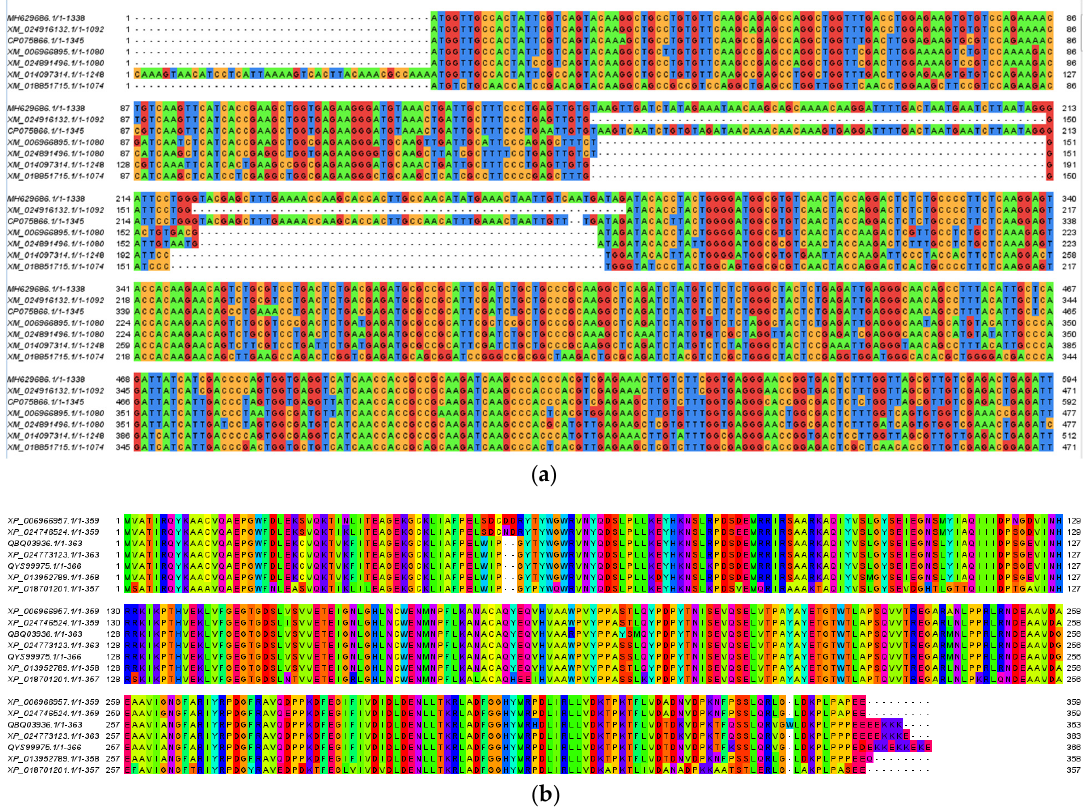
Figure 4. The percentage of identity in the cyanide hydratase of indigenous T. harzianum and four Trichoderma species and their catalytic triads, using ( a ) ClustalW and ( b ) Jalview.